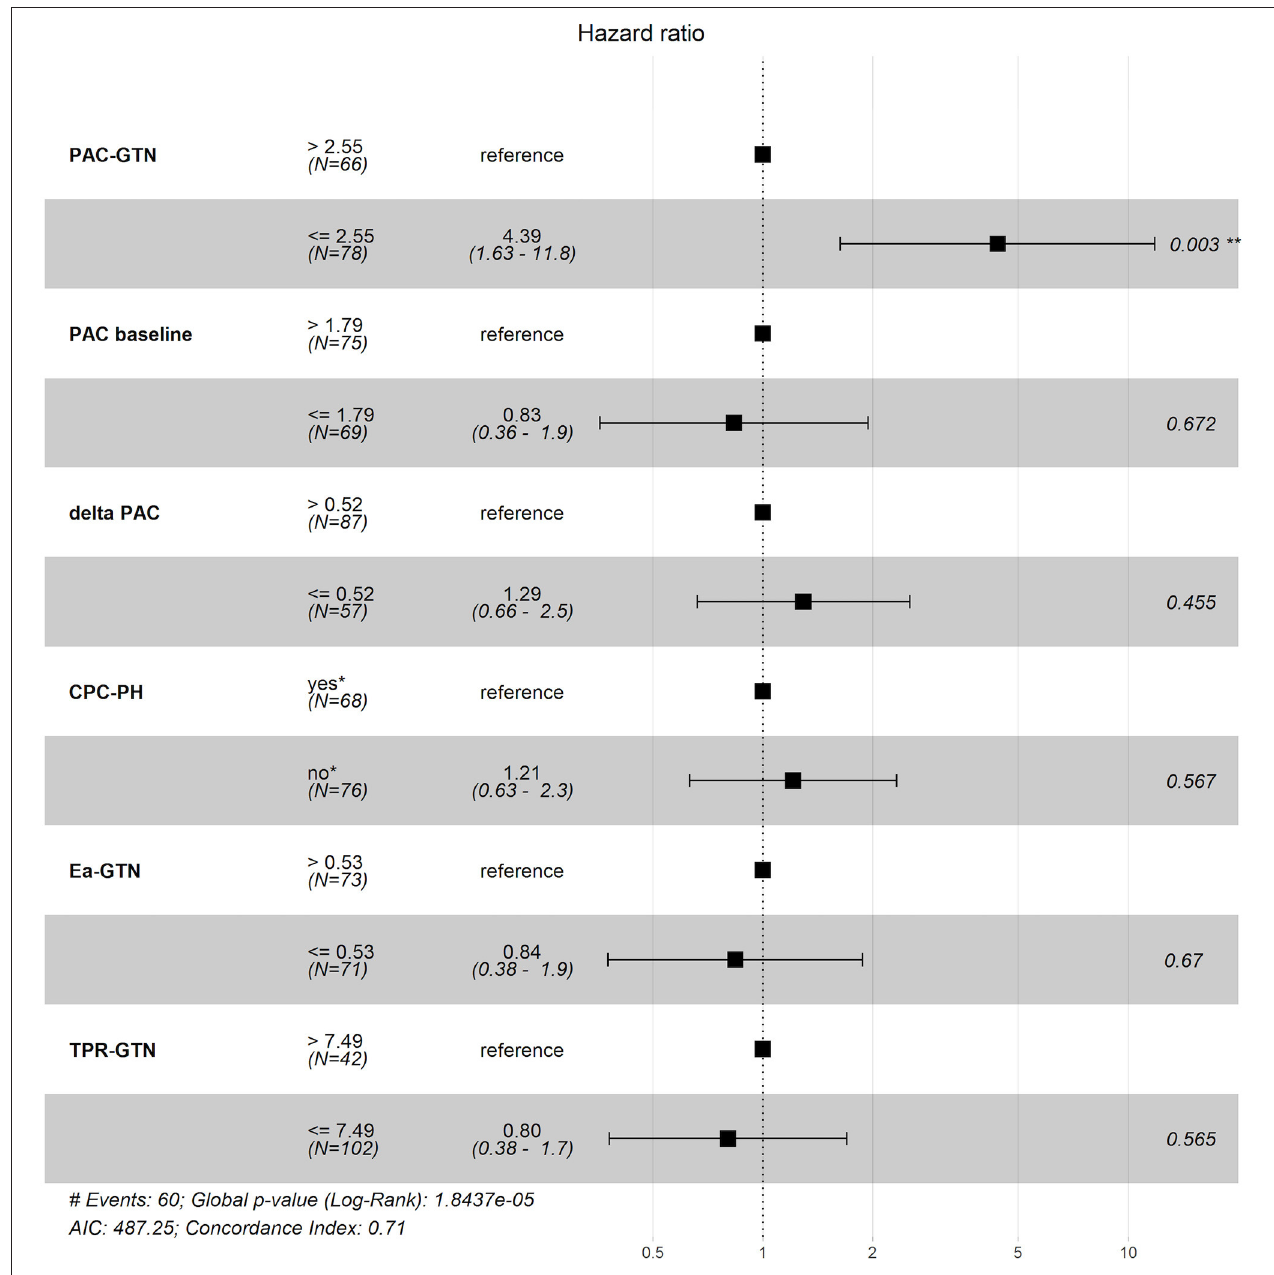
FIGURE 2 | Forest plot of different hemodynamic variables and their impact on prognosis. PAC, pulmonary arterial compliance; CpcPH, combined post- and pre-capillary pulmonary hypertension (“yes,” if pulmonary vascular resistance > 3 wood units and/or diastolic pulmonary gradient ≥ 7 mmHg); GTN, glyceryl trinitrate; Ea, pulmonary effective arterial elastance (calculated); TPR, total pulmonary